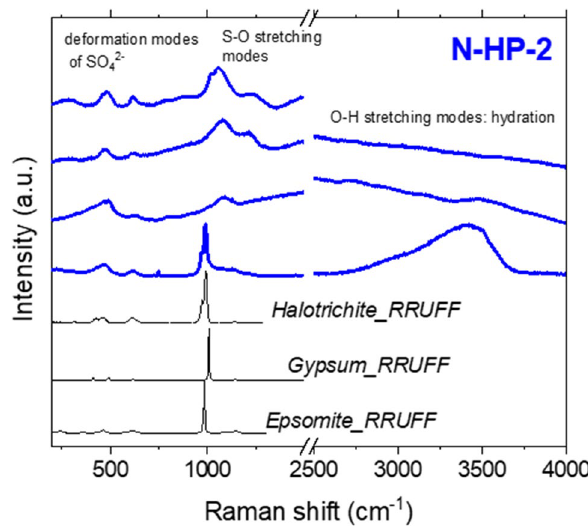
Figure 4. Raman spectra of the sample of the hot spring precipitate N-HP-2 composed of different types of sulfates. This spectroscopic technique allowed us to distinguish them (from the frequency shift around 1000 cm −1 ) and to study the hydration level (from the broad band at 3000–4000 cm −1 characteristic of the OH stretching modes of